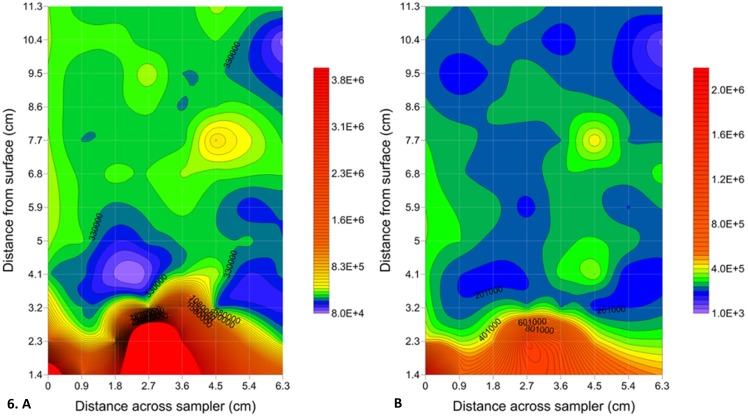
Two-dimensional contour plots showing surface gradients within bacterial subpopulations at St Kilda.Surface gradients seen across a distance of 6.3×11.3 cm using Surfer 10 (Golden Software, Inc.). Microbial abundance levels are indicated by a colour intensity scale in units of cells ml−1. A HDNA 2, microplate 2. B LDNA, microplate 2. Solid red circles indicate areas of abundance higher than the maximum contour level selected. A minimum contour interval value of at least 1000 was chosen based on maximum machine error. The faint gridlines show sample interval.